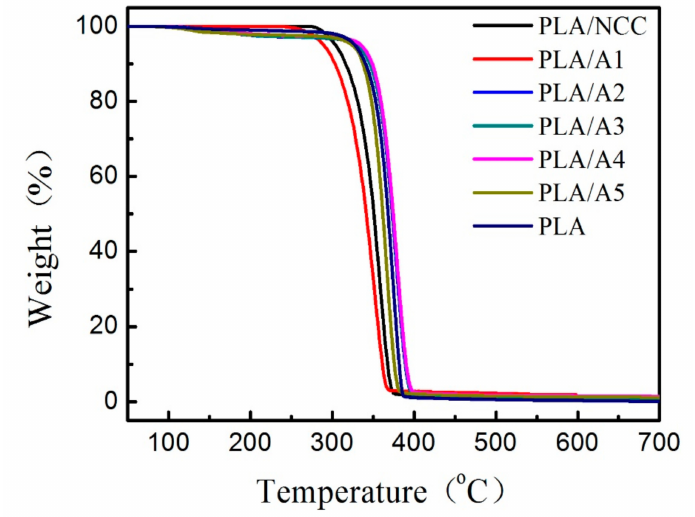
Figure 12. Thermal Gravimetric Analyzer (TGA) curves of PLA, PLA / NCC and PLA / NCC-HAP with di ff erent ratios of NCC to